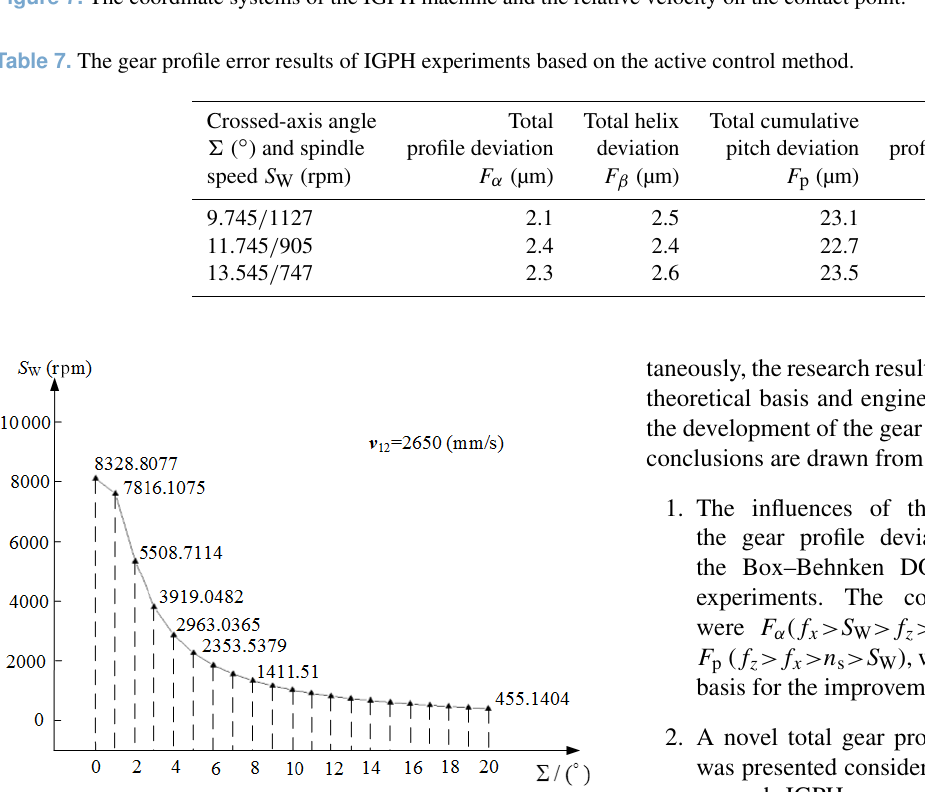
Figure 8. Rotation speed of the workpiece gear versus the crossed- axis angle for stable relative